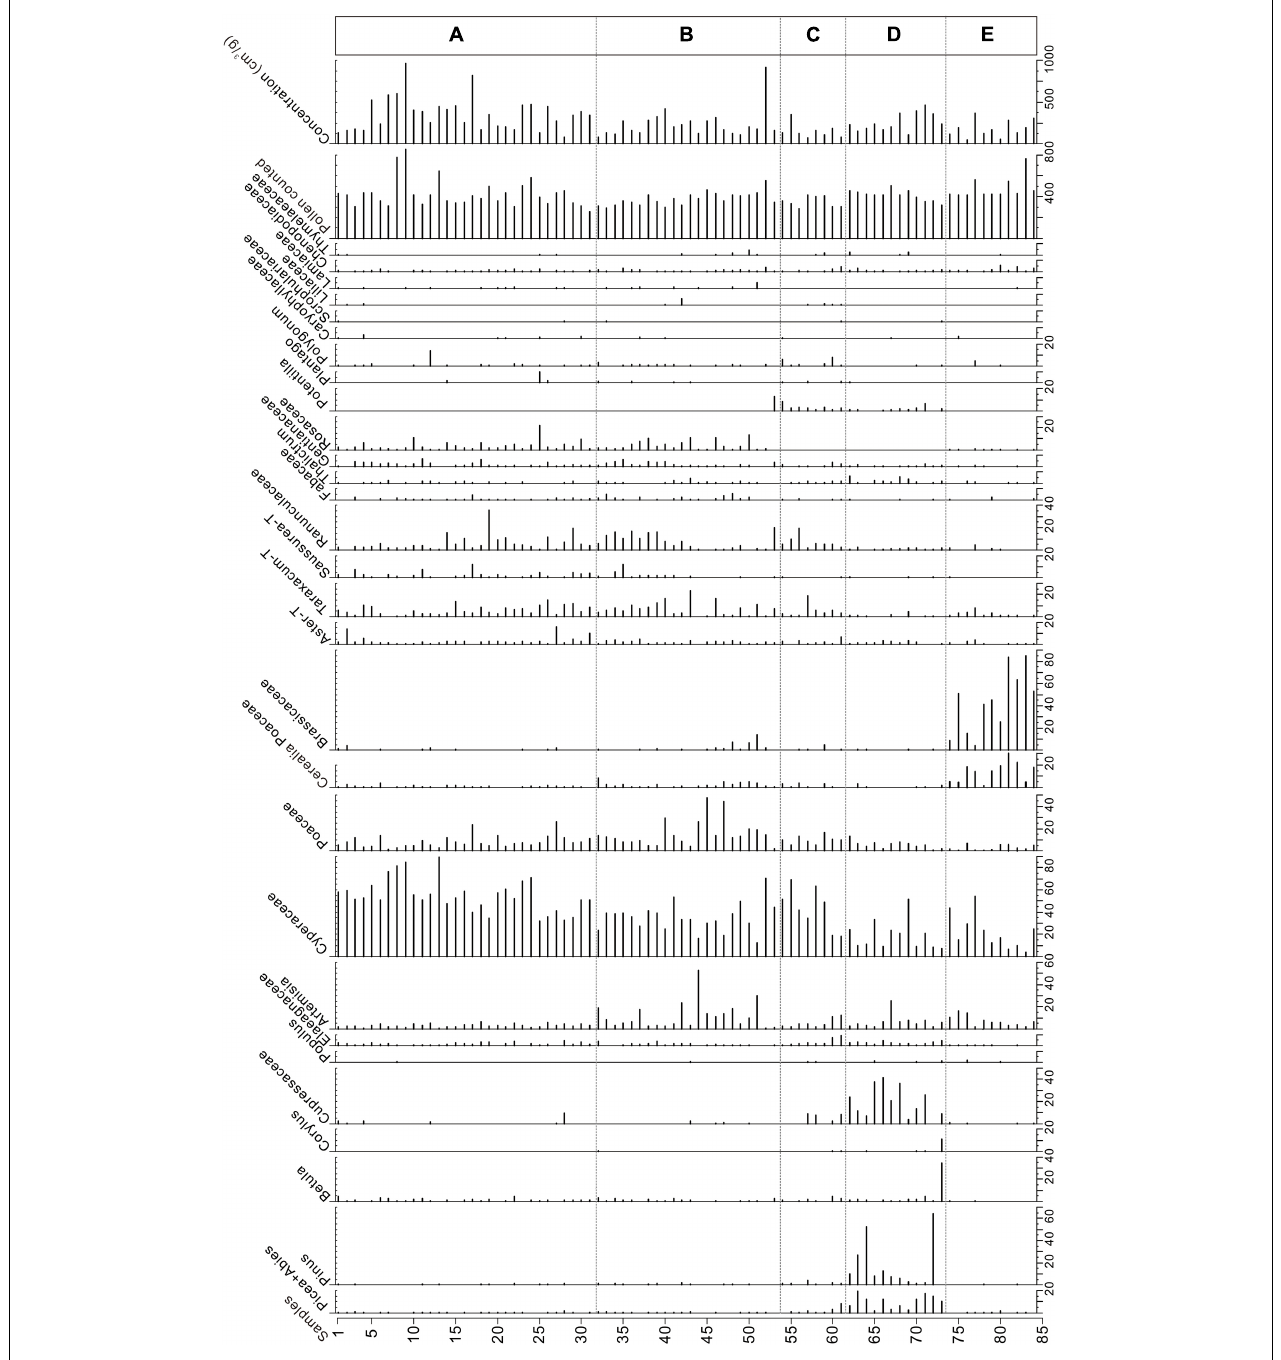
Table 2 . The pollen assemblage characteristics of each community are as follows: In alpine meadow, Cyperaceae is the predominant taxon, while other important pollen types are Poaceae, Ranunculaceae, Taraxacum -T, Artemisia , Aster -T, Saussurea -T, Gentianaceae, Rosaceae, Elaeagnaceae, and Polygonum . Cyperaceae,